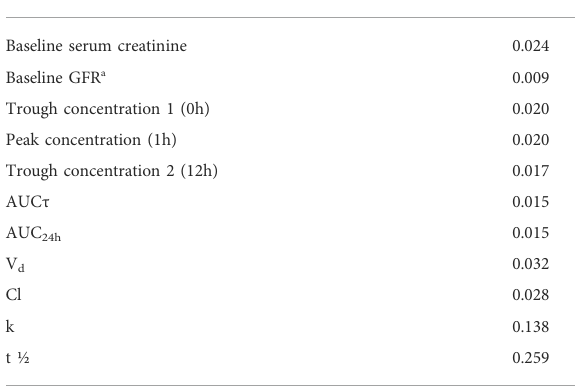
TABLE 3 The association between pharmacokinetic parameters of vancomycin and vancomycin-induced AKI. Pharmacokinetic